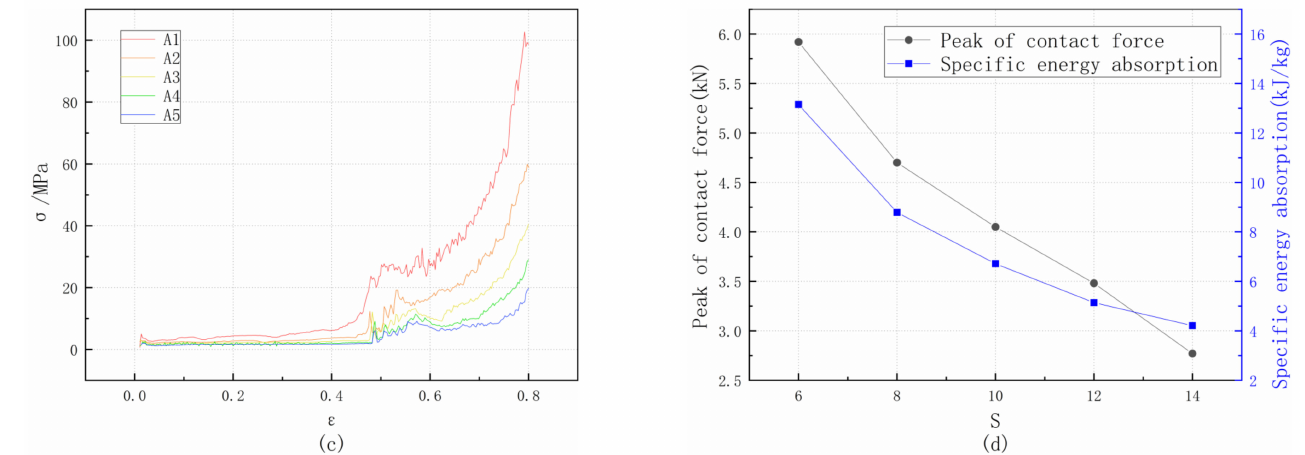
Figure 13. ( a ) Effect of different S on force; ( b ) effect of different S on energy; ( c ) effect of different S on stress–strain curve; ( d ) effect of different S on peak crushing force and specific absorption energy.